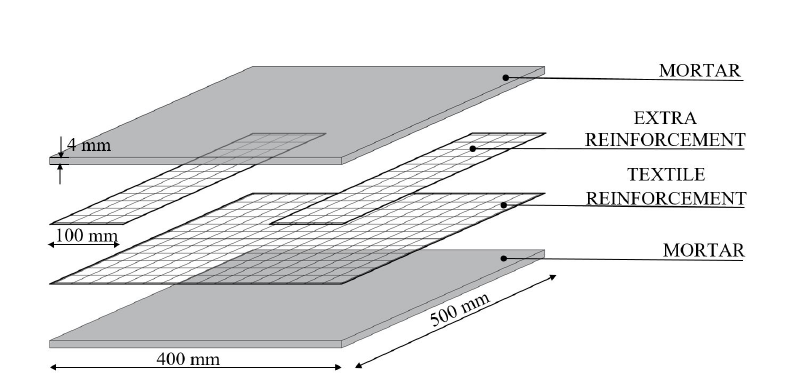
Figure 2. Geometry of glass-TRM (Textile Reinforced Mortar)